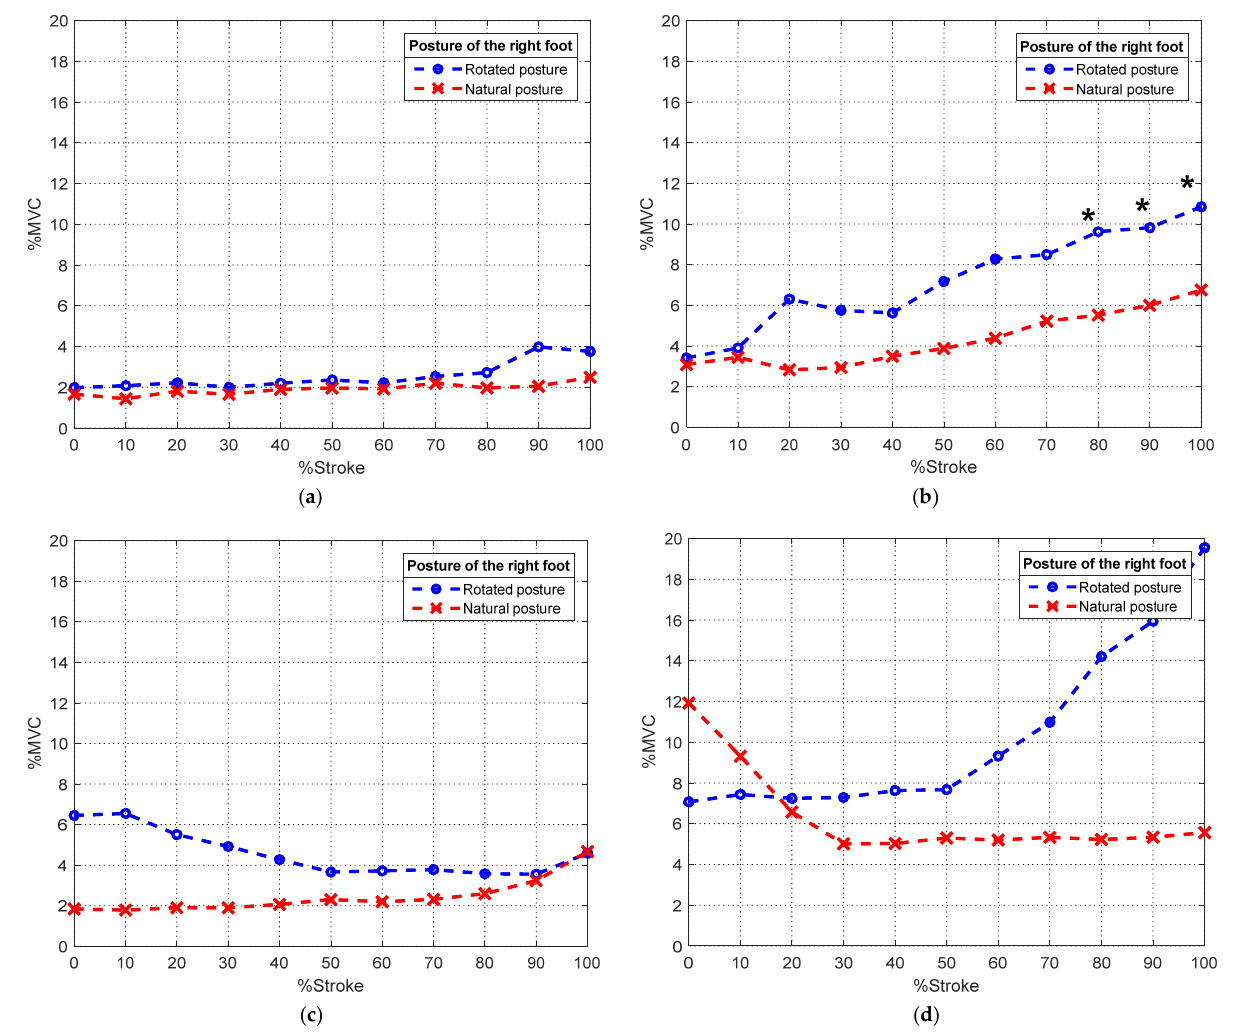
Figure 8. Average %MVCs on individual leg muscle for the rotation and natural styles as a function of %stroke (symbol * represents statistical significance at a significance level of 0.05 against the initial stroke). ( a ) Rectus femoris (foot posture: p = 0.002; %stroke: p = 0.043); ( b ) Gastrocnemius (foot posture: p < 0.001; %stroke: p = 0.002); ( c ) Peroneus longus (foot posture: p = 0.001; %stroke: p = 0.87); ( d ) Tibialis anterior (foot posture: p = 0.035; %stroke: p = 0.82)